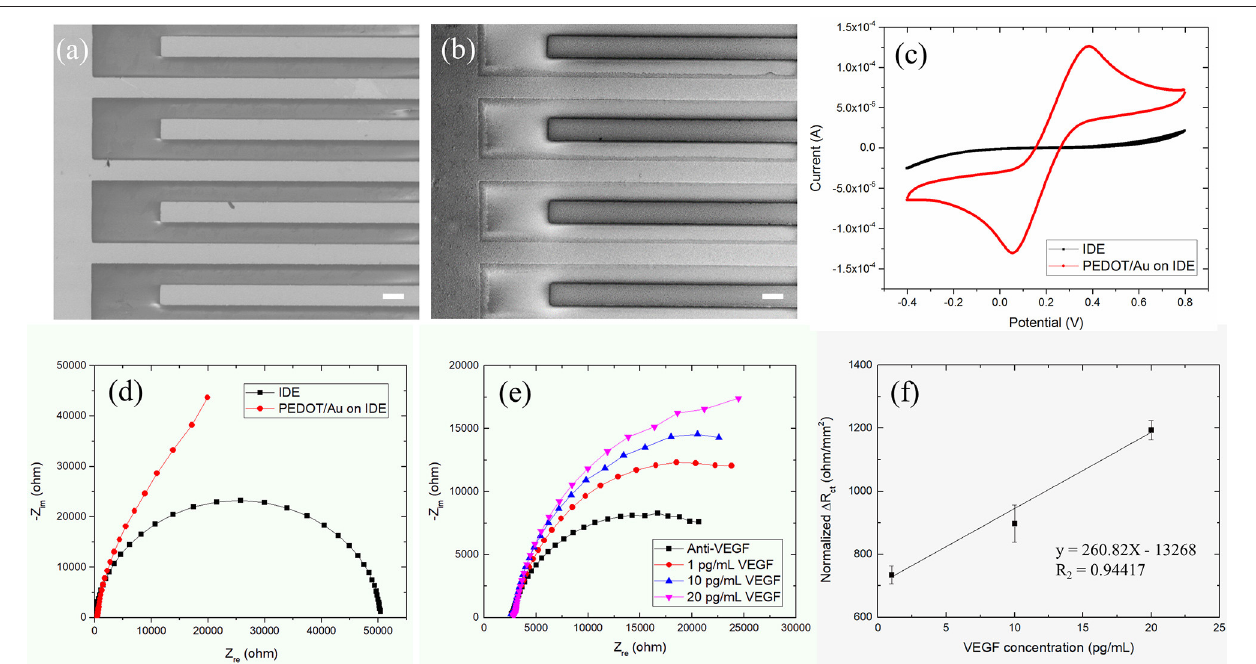
FIGURE 4 | (a,b) SEM images (scale bar 10 µ m) of a PEDOT/Au NP composite deposited on an IDE, (c) Nyquist plots, (d) cyclic voltammograms (or CVs) for a bare Au SPE and a PEDOT/Au NP composite-coated IDE (e) Nyquist Plot of impedance spectra obtained from the increasing concentration of VEGF from 1 to 20 pg/mL on a Au IDE (f) Linear plot of 1 R ct as a function of VEGF concentration.